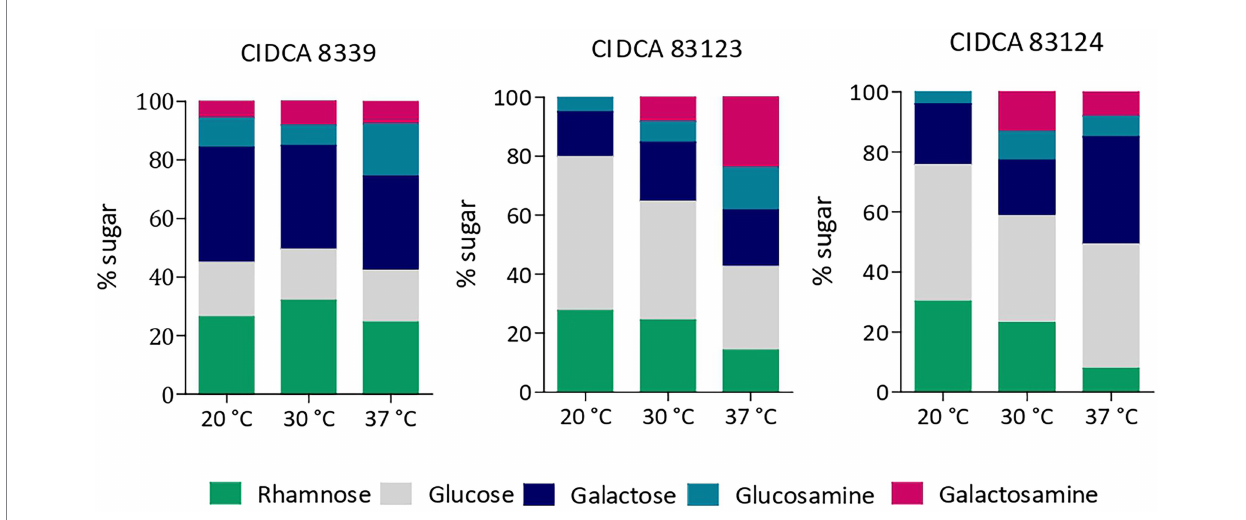
FIGURE 3 Monosaccharide composition of EPS produced by L. paracasei CIDCA 8339, CIDCA 83123 and CIDCA 83124 in milk at 20 ° C, 30 ° C, and 37 ° C. Standard deviation in monosaccharide composition was between 0.2 and 4 depending on the percentage of each